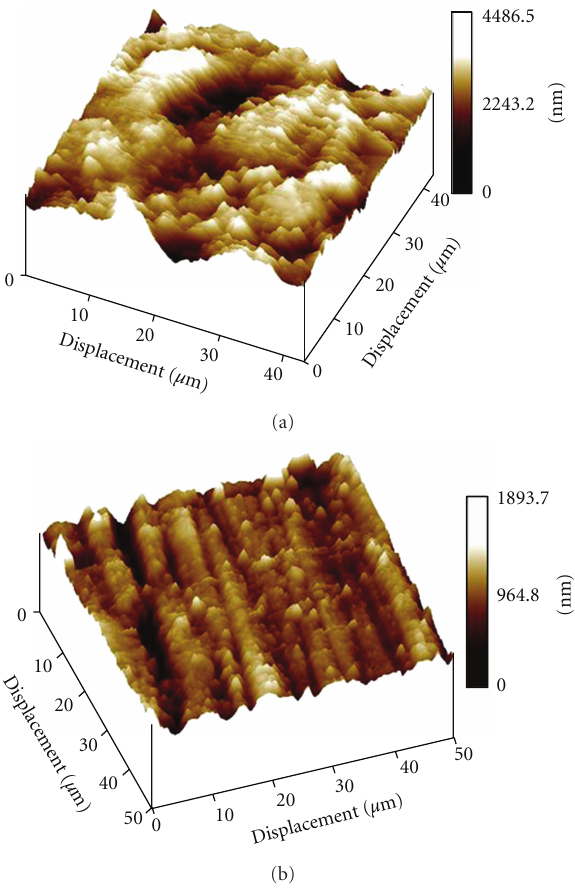
Figure 5: 3D AFM image of AZ91D showing (a) a corroded surface (Figure 4(a), insert A) and (b) an nonattacked zone (Figure 4(a), insert B) after 8h of immersion in untreated 5% NaCl solution saturated with Mg(OH) 2 at pH 9 and 25 ◦